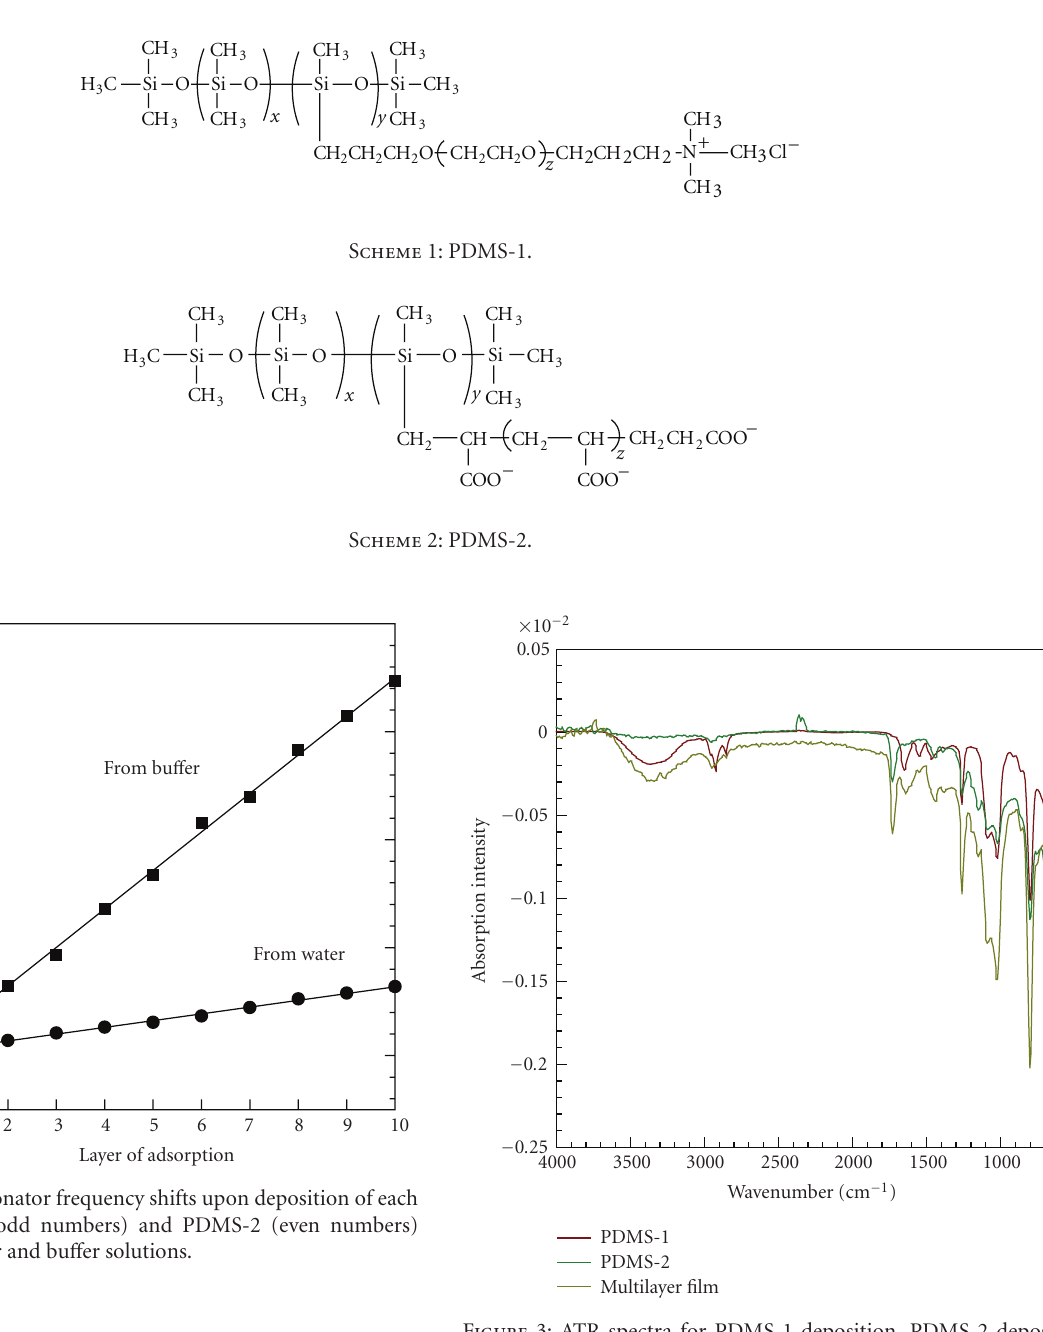
Figure 3: ATR spectra for PDMS-1 deposition, PDMS-2 deposi- tion, and the 12 PDMS-1/PDMS-2 bilayer film on gold